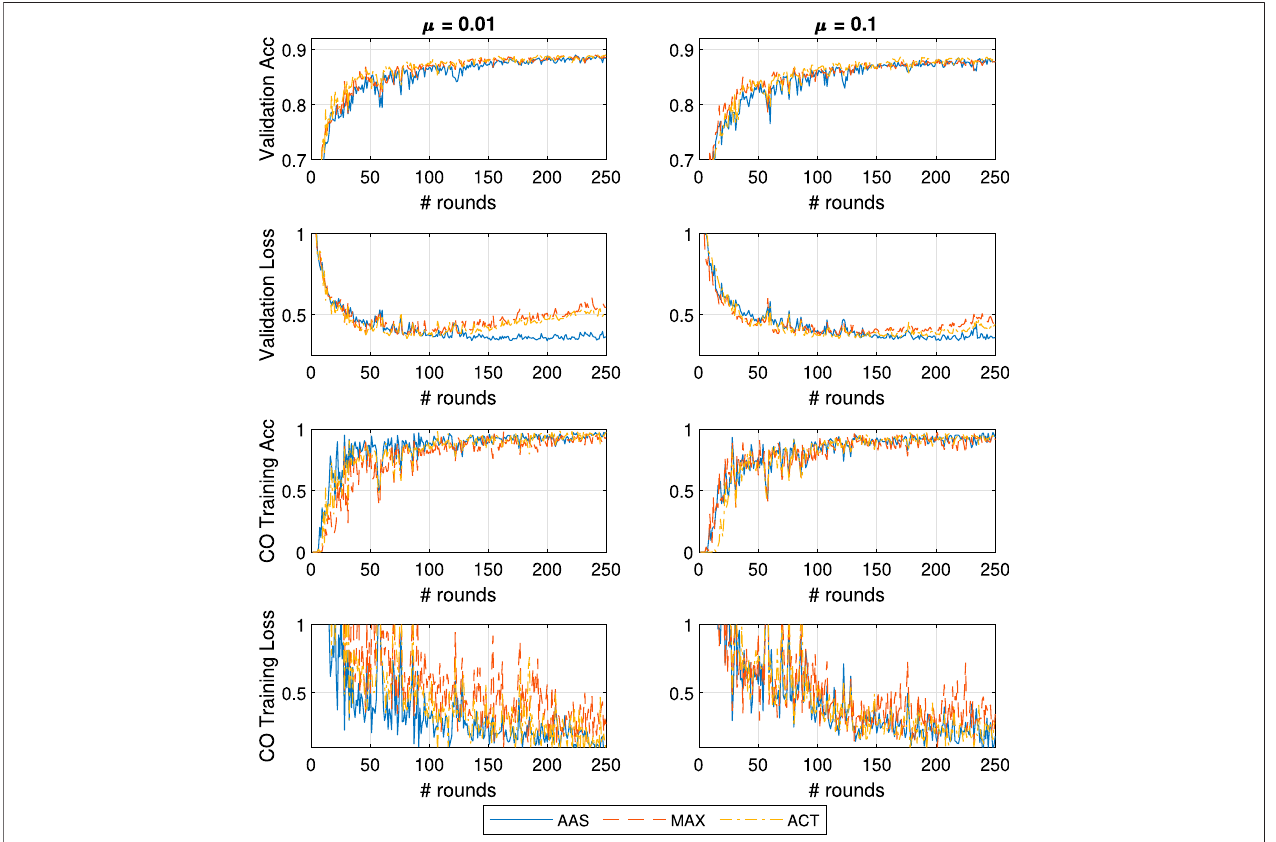
FIGURE 9 | General and CO-speci fi c accuracy and loss results obtained when testing, with an extra CNN layer, all three methods in combination with FedProx using the FMNIST in the case of fl eeting data.